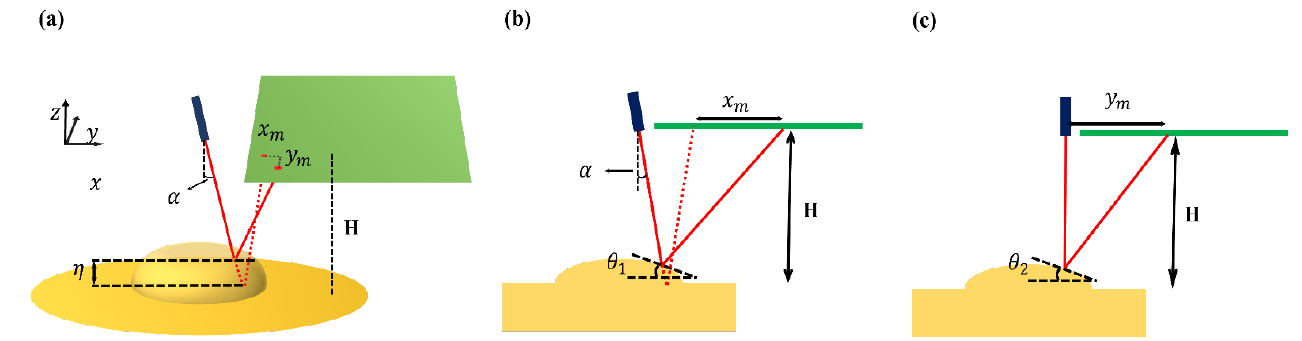
Figure 4. ( a ) Laser light reflection by moving oil surface; ( b ) XZ plane view; ( c ) YZ plane view.